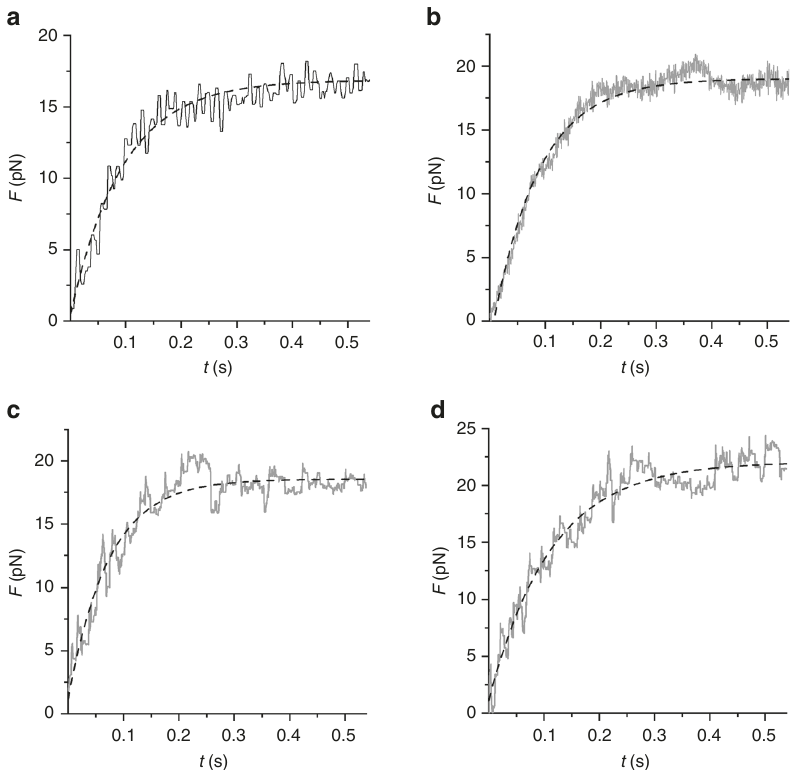
Fig. 3 Rate of force development. Upper row: time course of initial force development ( a , Frame 1 from Fig. 2b) and force redevelopment following a large release ( b , Frame 8 from Fig. 2c). The different trace thickness in a and b is due to different acquisition rates (500 and 5000 points s − 1 , respectively). Dashed lines are single exponential fi ts. Lower row: Model simulation of initial force development ( c ) and force redevelopment following a large release ( d ), using 16 available myosin heads and a series compliance of 3.7 nm pN − 1 . Dashed lines are single exponential fi ts. τ , calculated from fi ts to experimental traces as in a and b (0.15 ± 0.09 s, mean ± SEM, n = 34), is not signi fi cantly different from that calculated from fi ts to simulated traces in c and d (0.11 ± 0.06 s, mean ± SEM, n = 34) (see related Supplementary Fig. In Fig. 4d, the various simulated mechanical parameters are plotted as a function of N ( fi lled circles). The relations for F 0 and P max intersect the dashed lines (experimental values) at N = 16.